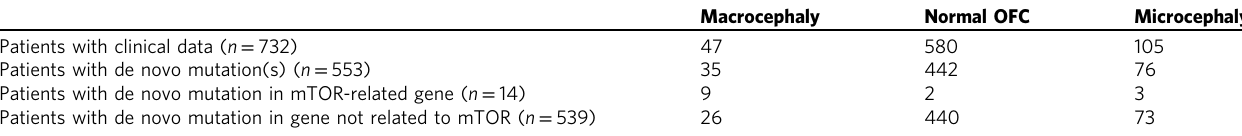
Table 2 Number of patients with macrocephaly, normal OFC, and